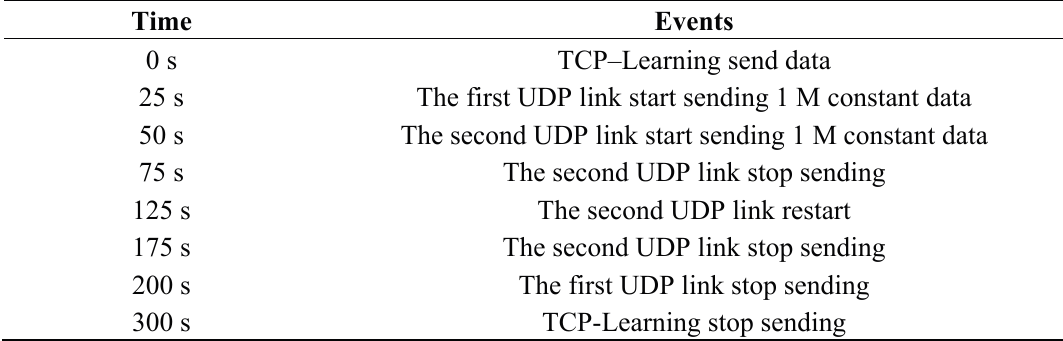
Table 2. The corresponding relation of time and events.